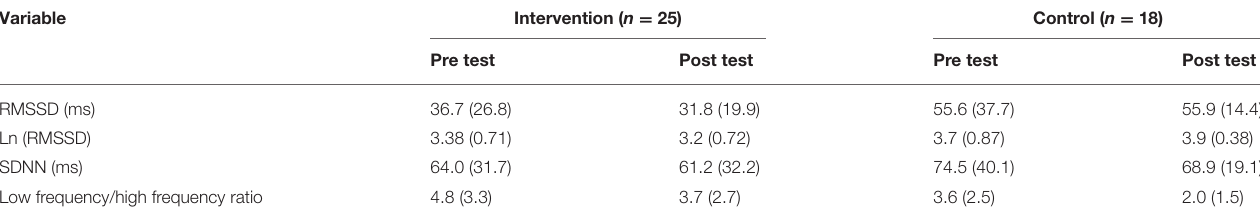
TABLE 6 | Heart rate variability before and after a dance/movement workshop